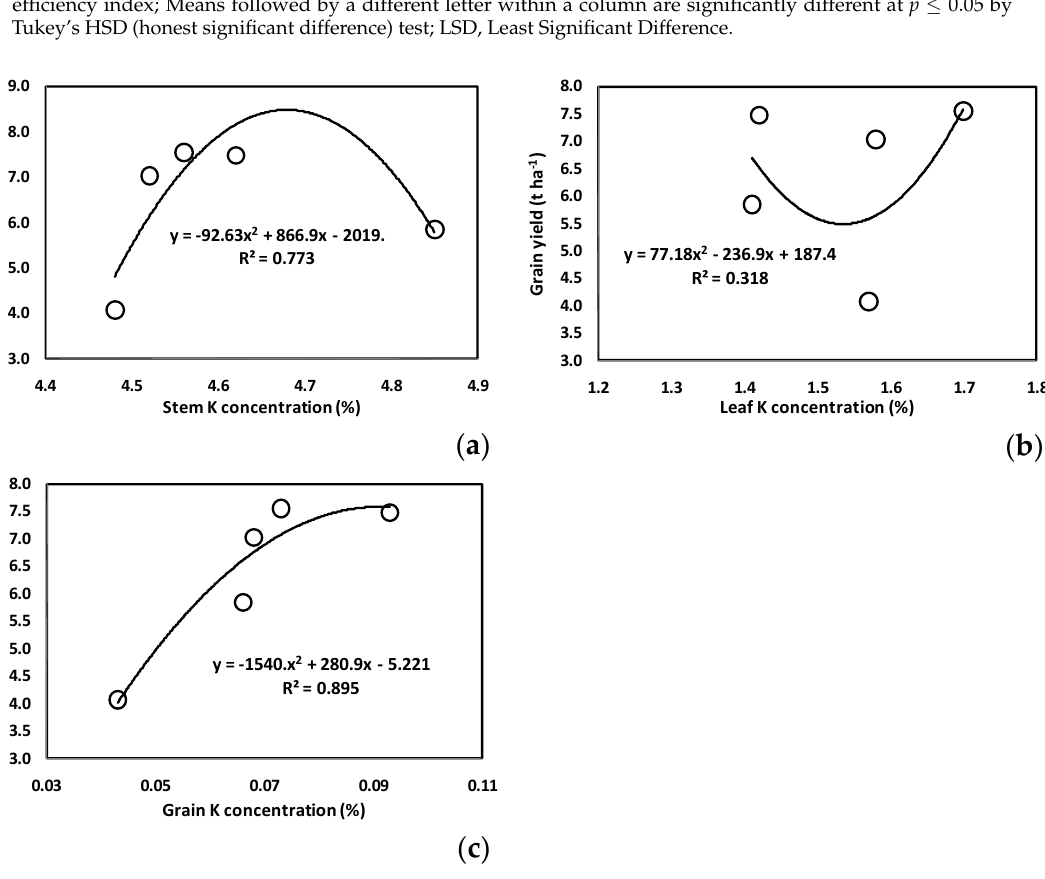
NS, non-significant; DAT, days after transplanting; KHI, potassium harvest index; KMEI, potassium mobilization efficiency index; Means followed by a different letter within a column are significantly different at p ≤ 0.05 by Tukey’s HSD (honest significant difference) test ; LSD, Least Significant Difference.